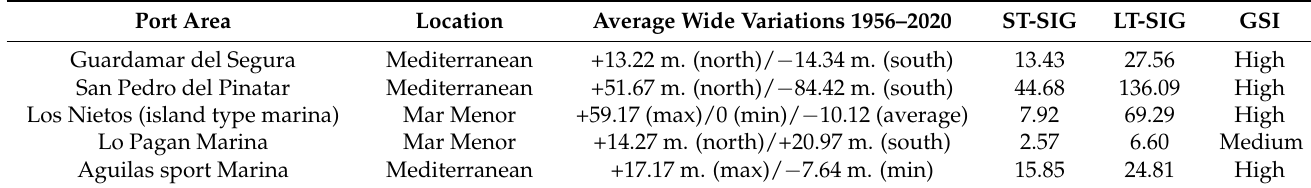
Figure 4. Aggregated tessellated large-scale distribution of port areas impact indicators in the study area. Table 4. Some examples of values for spatiotemporal impact